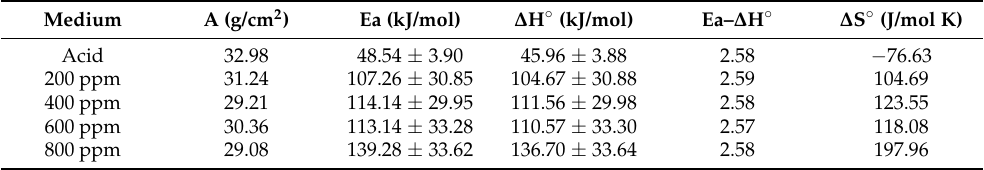
Table 3. Activation parameters of MS dissolution in 1 M H 2 SO 4 without and with inhibitor.